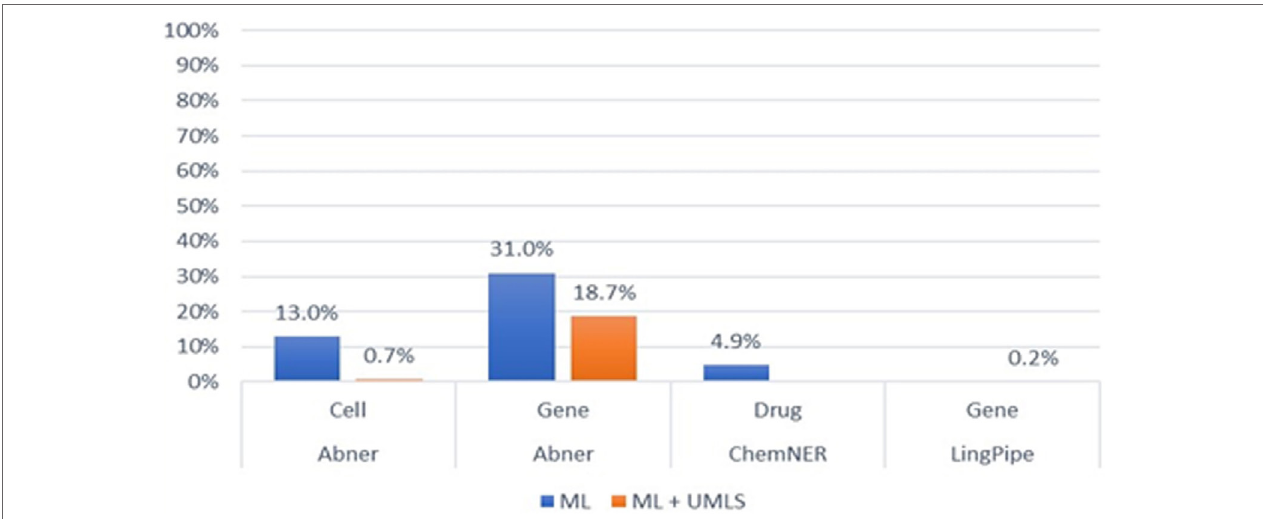
FigUre 9 | F- scores of the machine learning and the Unified Medical Language System (UMLS)-combined machine learning-connected systems.